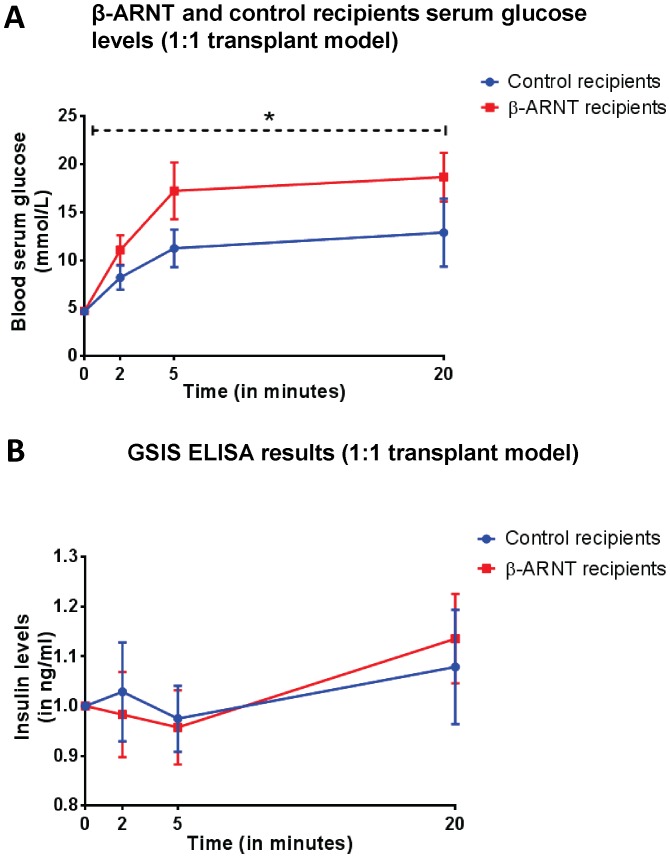
Glucose metabolism and insulin secretion in β-ARNT and control recipients at day 14 post-transplantation (in 1∶1 transplant model).(A) Serum glucose levels measured in the β-ARNT and control recipients tended to be higher in β-ARNT recipients on day 14 post transplantation. (n = 7–8 per group) (Two-way ANOVA test. p value = 0.0396). Data are presented as means ± SEMs. (B) Glucose stimulated insulin secretion measured (in ng/ml) by ELISA indicating no difference in the first and second phase of insulin secretion between the β-ARNT and control recipients at day 14. (n = 7–8 per group). Data are presented as means ± SEMs.